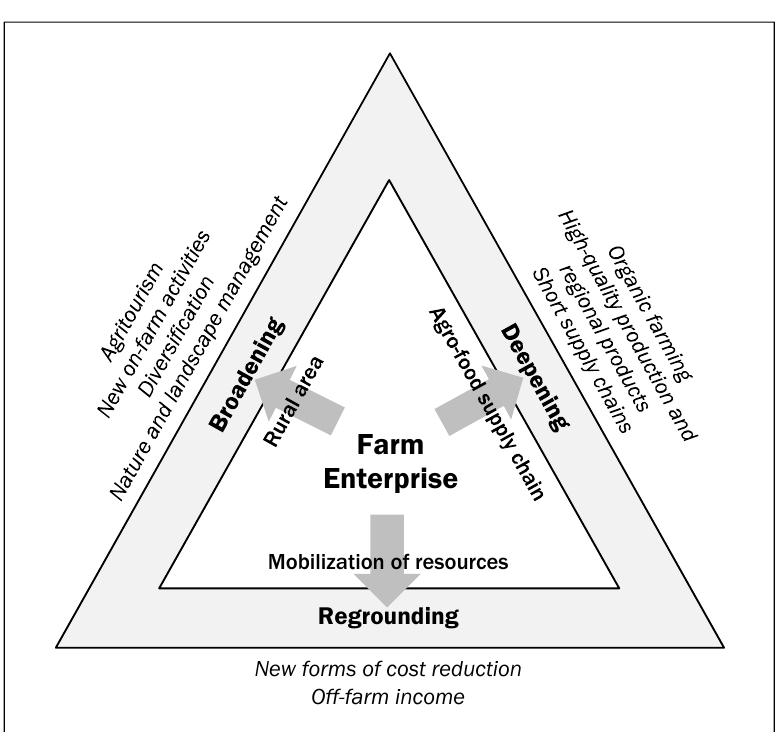
Figure 1. Boundary Shifts: The “Deepening-Broadening-Regrounding”